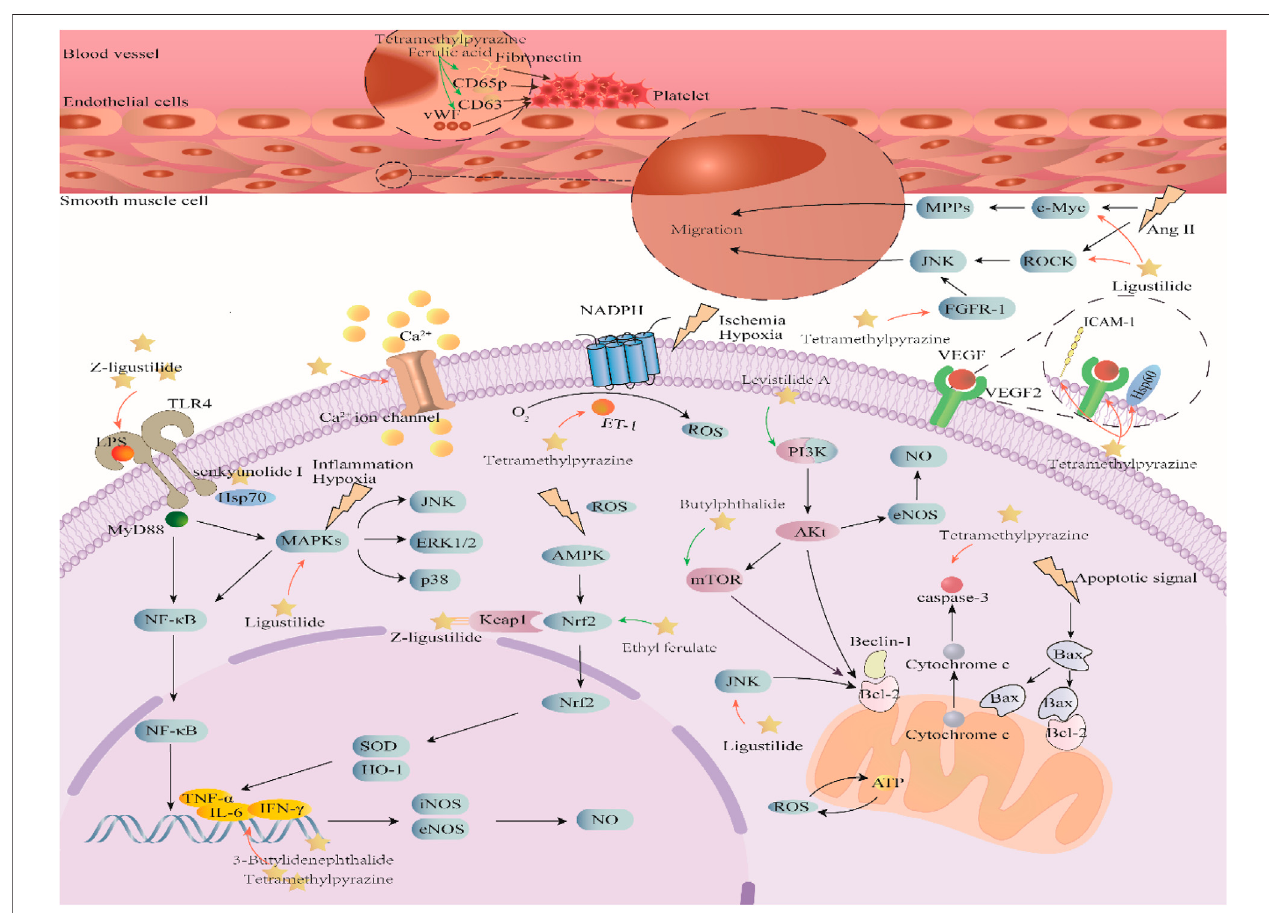
FIGURE 2 | Mechanism and pathway of Ligusticum chuanxiong Hort. in the treatment of CVDs.